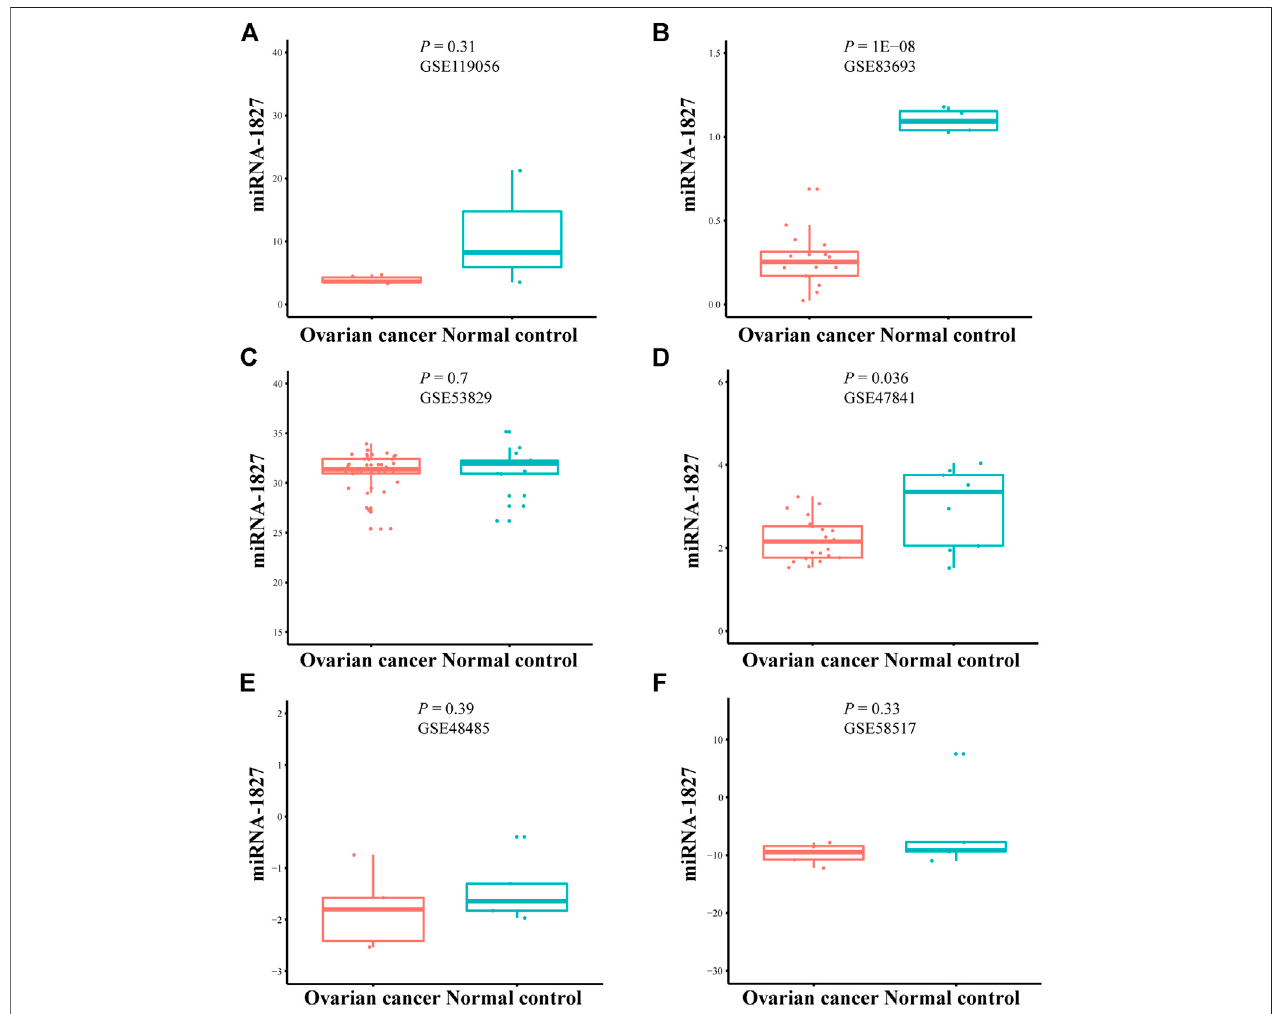
FIGURE2| Downregulation of miRNA-1827 inthe selected microarrays fromtheGEOdatasets. (A) GSE119056. (B) GSE83693. (C) GSE53829. (D) GSE47841. (E) GSE48485. (F) GSE58517.